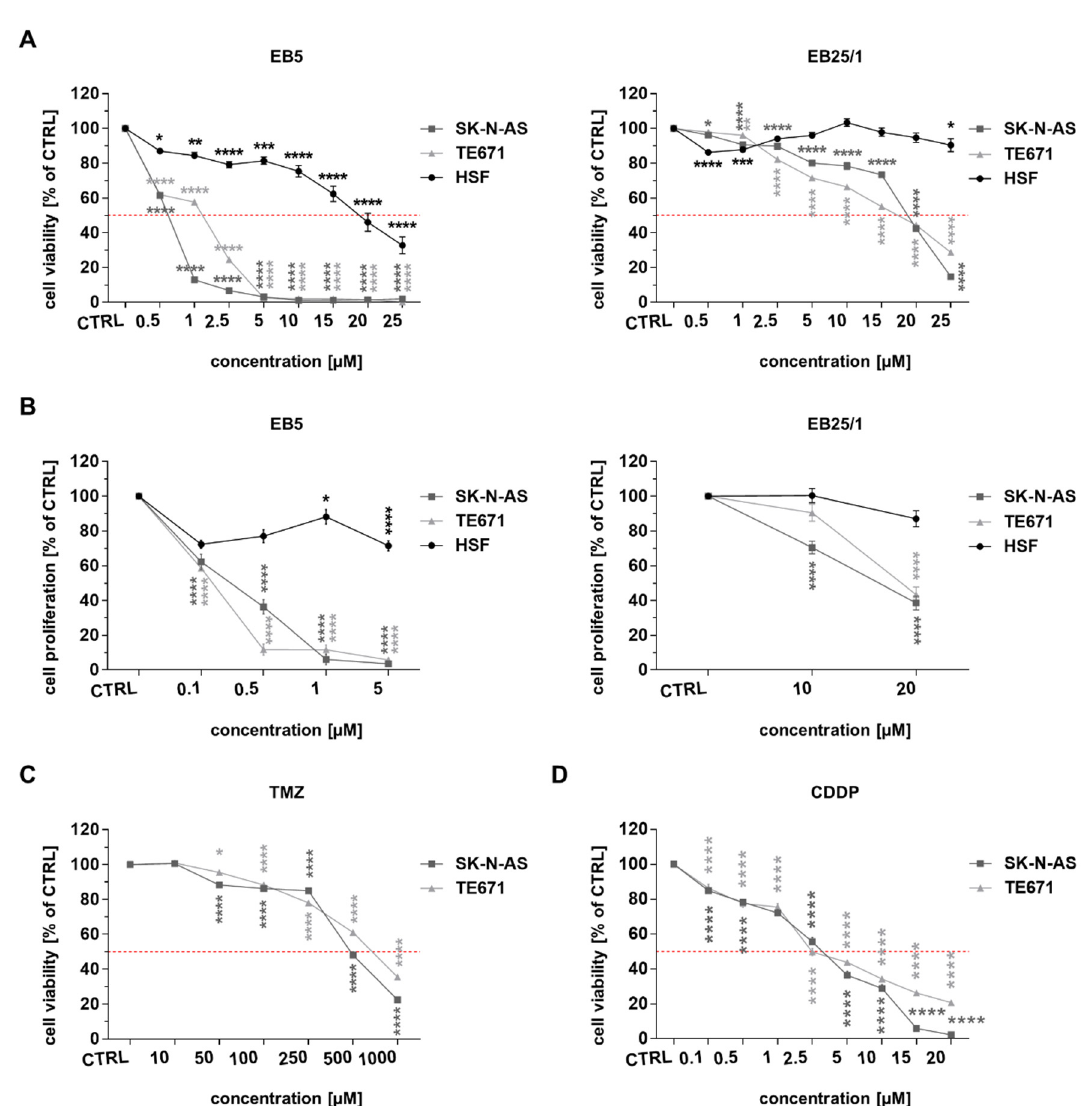
Figure 2. ASBDs reduce viability and proliferation of pediatric cancer cells stronger than TMZ and CDDP in vitro, whereas they show moderate activity against normal cells. SK-N-AS, TE671 and HSF cell lines were treated with ASBDs for 96 h and then analyzed with MTT metabolism assay for cell viability/survival, or for 48 h with BrdU incorporation test for cell proliferation. ( A ) The line graph presents cell viability of SK-N-AS, TE671 and HSF cells after treatment with EB5 or EB25/1.